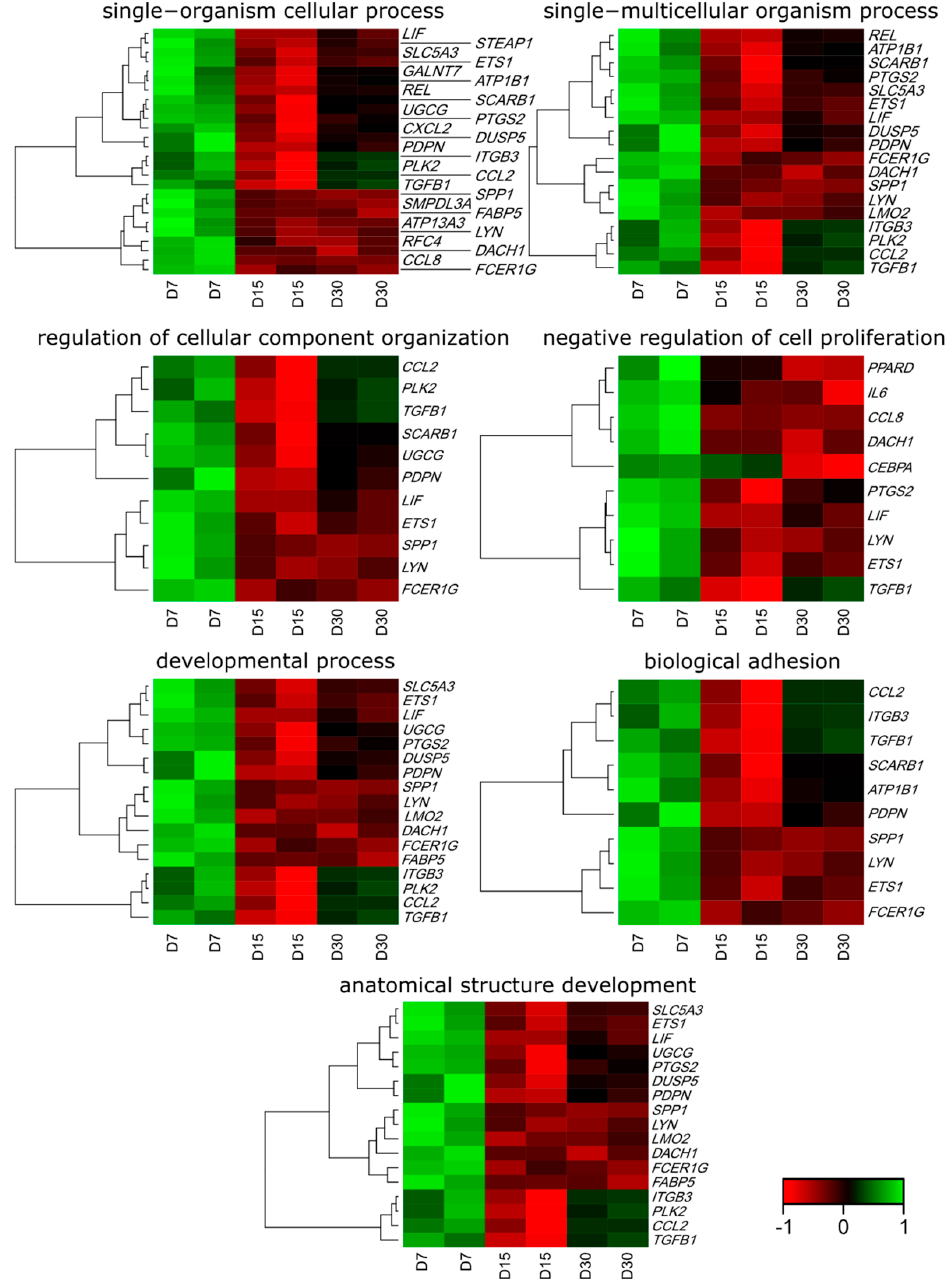
Figure 2. Heat map representation of differentially expressed genes belonging to the anatomical structure development, biological adhesion, developmental process, negative regulation of cell proliferation, regulation of cellular component organization, single − multicellular organism process, and single − organism cellular process gene ontology (GO) BP terms.